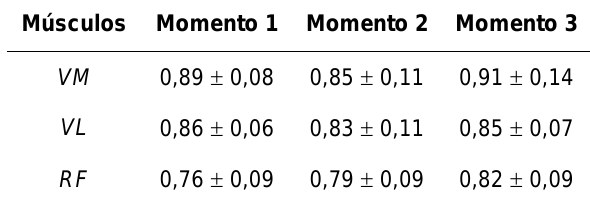
Tabela 1. Média e desvio padrão dos